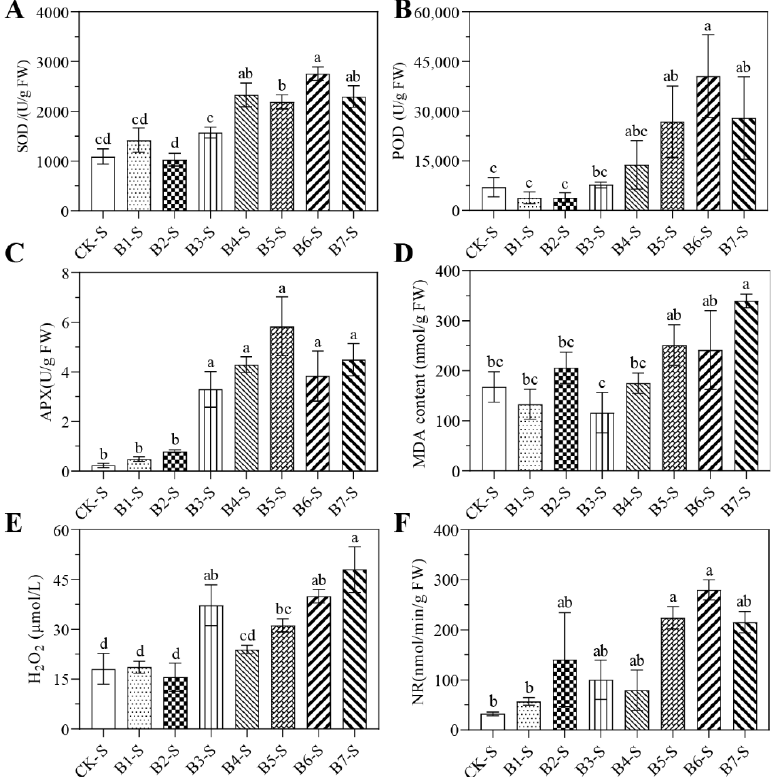
Figure 6. Physiological indices of flue-tobacco seedlings under different B concentrations. Note: physiological indices of flue-tobacco seedlings under different B concentrations. ( A ) SOD activity. ( B ) POD activity. ( C ) APX activity. ( D ) MDA content. ( E ) H 2 O 2 content. ( F ) NR activity. Data are means ± standard errors ( n = 3). Within a column, values followed by different lower letters are significantly different at p < 0.05 following Duncan’s multiple-range test.